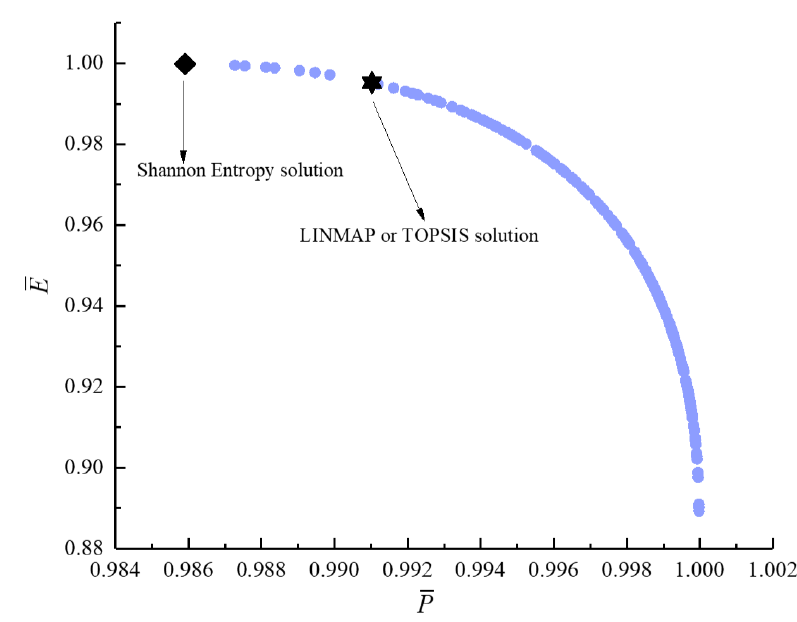
Figure 16. Bi-objective optimization on P − E .